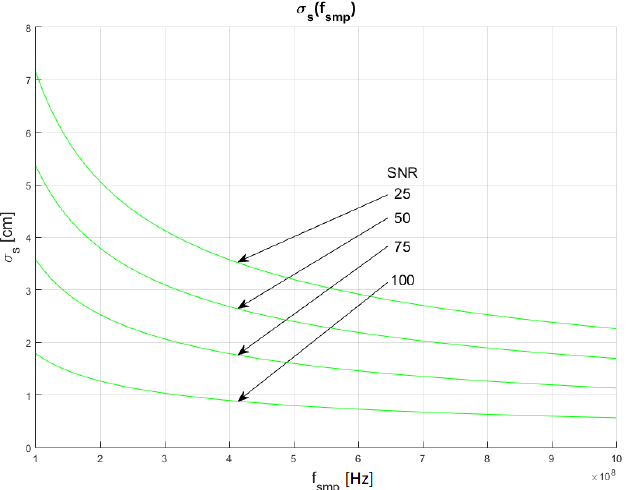
Figure 11. Plots of the dependance of the measurement’s uncertainty calculated using Equation (16) for signal parameters shown in Table 4. Comparable results are shown in Figure 7.